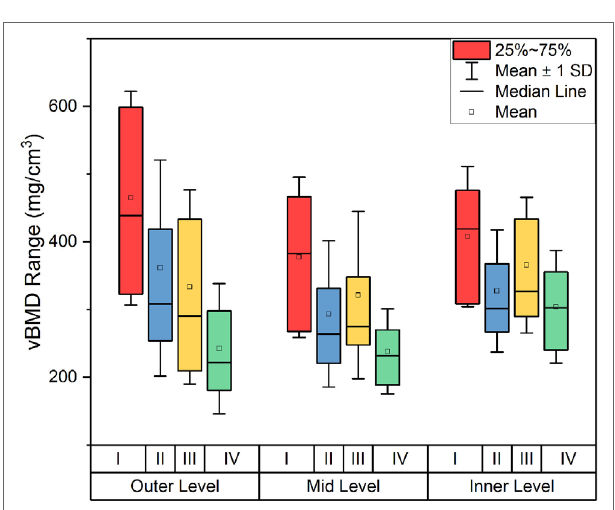
FigUre 5 | Volumetric bone mineral density (vBMD) of OA samples according to both cartilage grading and